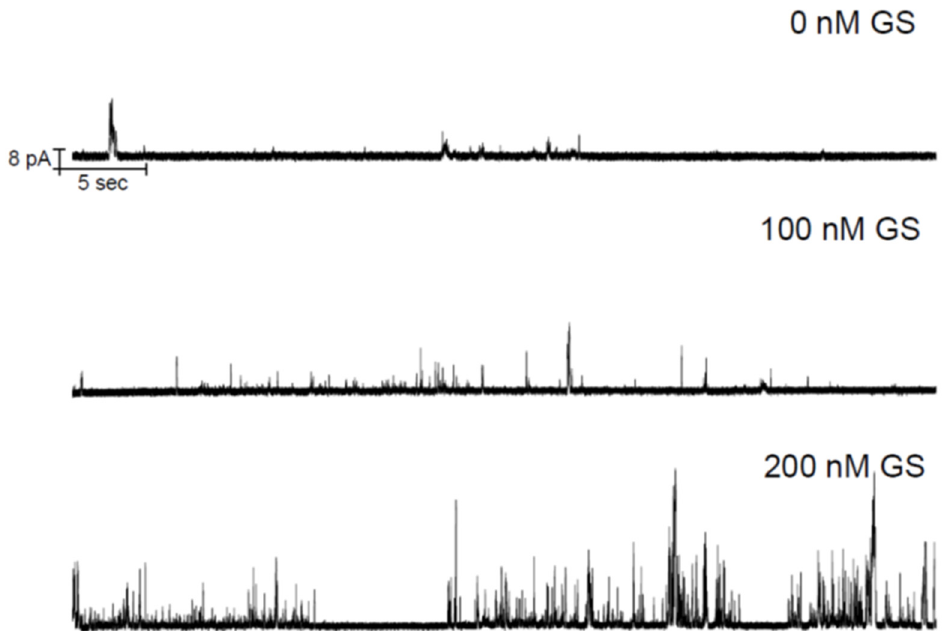
Figure 2. GS increases the chemotherapy drugs (CD)-induced ion pore induction potency. TCC (90 µ M) alone permeabilizes lipid bilayer membranes by inducing nonzero current events (top panel). The middle and bottom panel represent the CD-induced current events being influenced by the effects of 100 nM and 200 nM GS, respectively, which are added into the aqueous phases in both chambers. As GS effects are added into the CD pore formation potency, the CD pore appearance frequency increases. So, we should not use too high CD concentrations to avert reaching at (or crossing over) the highest limit in the membrane current record, which is measurable in EP experiments. The traces were filtered at 20 kHz. POPE:POPS:POPC = 5:3:2, 500 mM NaCl + 90 µ M TCC ( cis side of the membrane), 500 mM NaCl + 0 µ M TCC ( trans side of the membrane), 100 mV, pH 7.4. 200 nM GS alone could not induce ion conductance across the membrane; see Figure S1 [9].